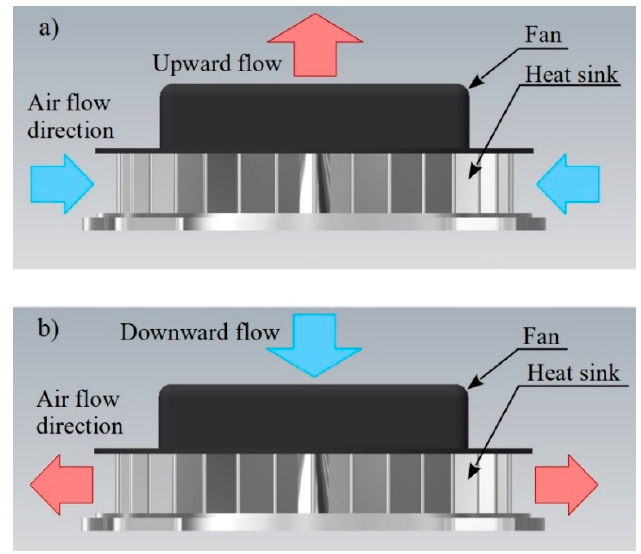
Figure 4. The axial fan cooling configurations: ( a ) upward flow, ( b ) downward flow. Table 1. Typical uncertainty of measured